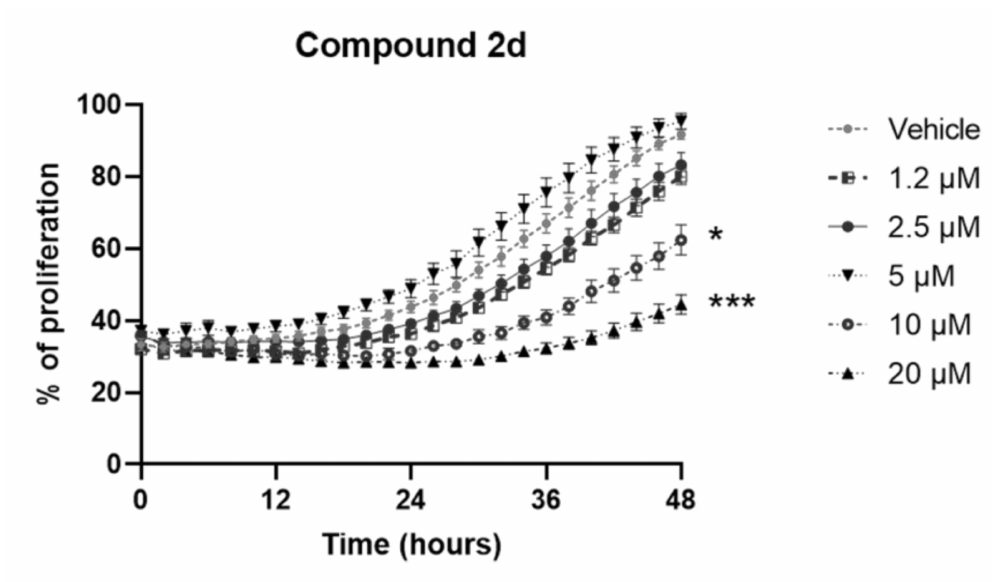
Figure 5. Antiproliferative effect of the analog compound 2d on MC38 cell line treated for 48 h (1.2–20 µ M). Data are expressed as mean values ± SEM. Data sets were compared with two-way analysis of variance (ANOVA) test followed by Dunnett’s correction (* p < 0.05, *** p <